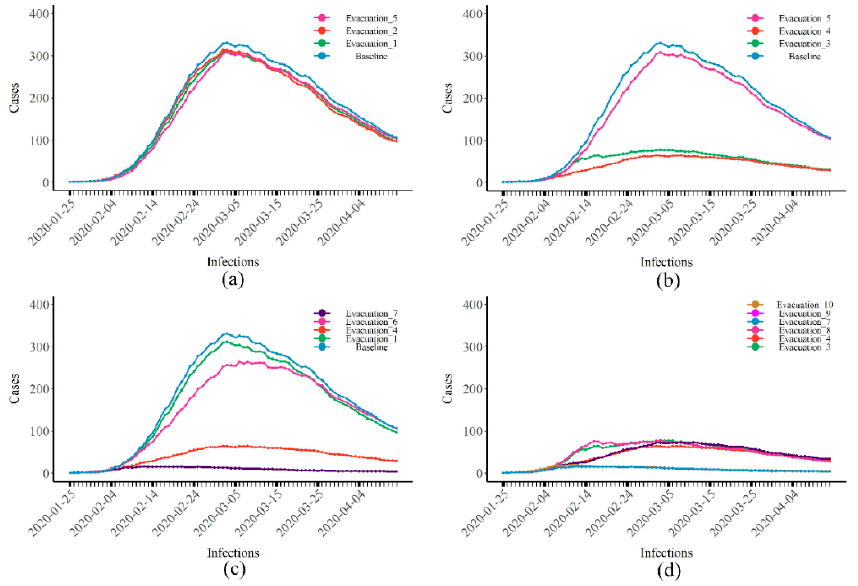
Figure 3. The epidemic curves of COVID-19 when the control measure was evacuation. ( a ) Results of changing the start time of evacuation when the number of evacuees was low; ( b , c ) results of changing ( b ) the number of evacuees and ( c ) the identity of evacuees; ( d ) results of changing the social intentions of passengers when the number of evacuees was high. The number of cases represents people in state I on that day, not the number of newly reported cases each day.